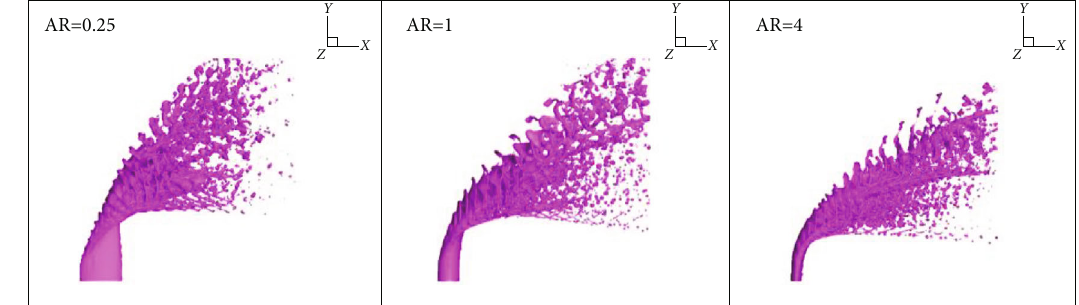
Top The nearest point to the injector where the liquid intersects the boundary